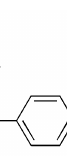
Figure 4. Chemical structure of nitrone, 1